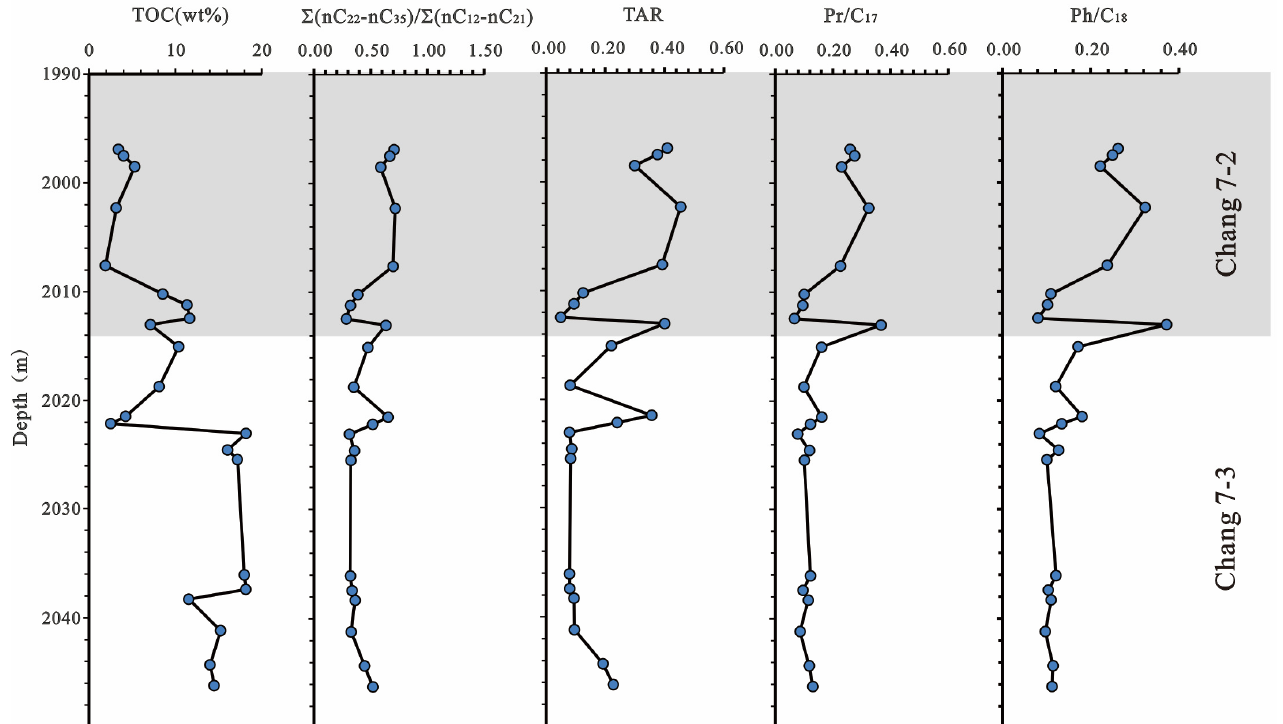
Figure 6. The depth trends of the wax indexe (nC 22 − nC 35 )/(nC 12 − nC 21 ), TAR (C 27 + C 29 + C 31 )/(C 15 + C 17 + C 19 ), ratios of Pr/C 17 and ratios of Ph/C 18 for source rock samples from well CYX. Additionally, the terrigenous/aquatic ratio (TAR): (C 27 + C 29 + C 31 )/(C 15 + C 17 + C 19 ), can be used as an indicator in terms of the source input [49]. By measuring the